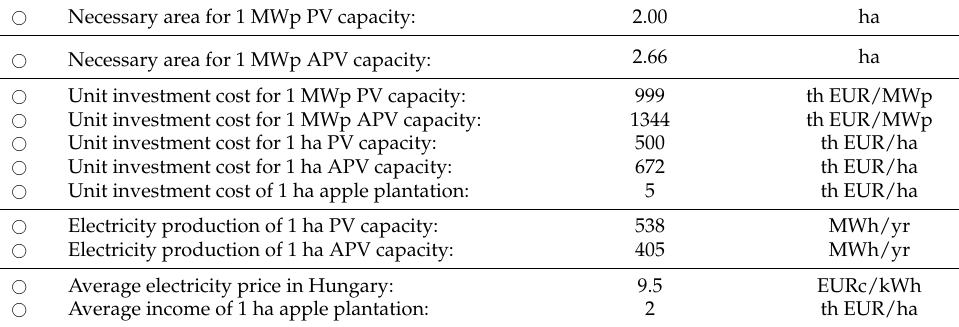
Table 5. Economic data of large-scale Kaposv á r PV systems compared to the APV